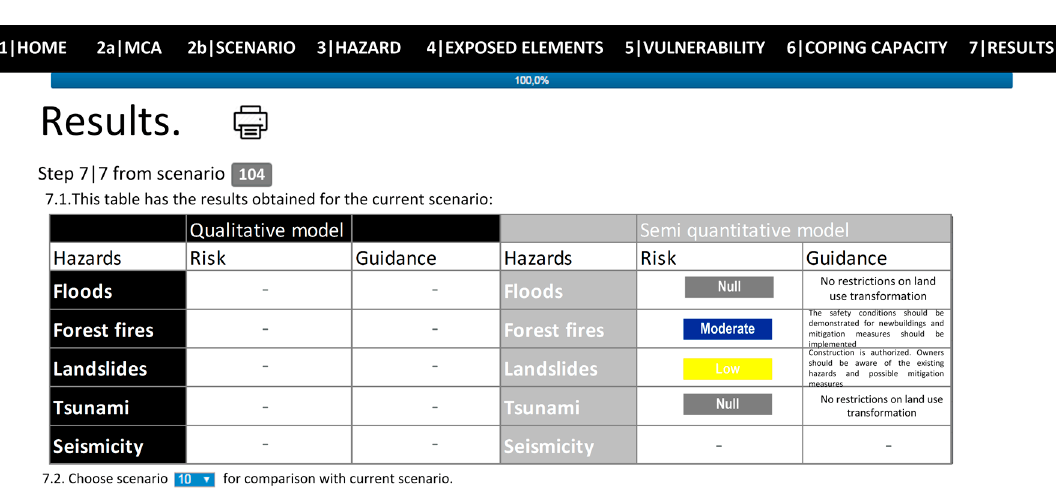
Figure 11. Polygon used in third scenario.